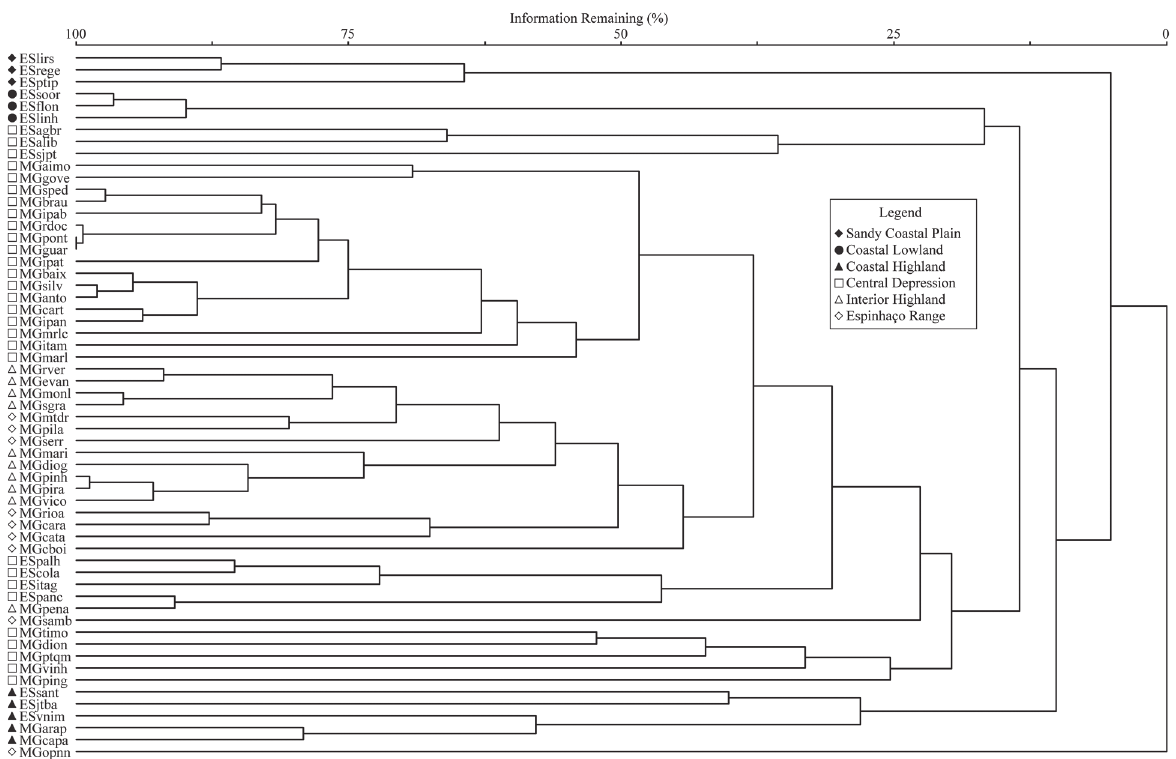
Figure 2 - Cluster analysis (UPGMA) for 59 sites (including outliers) within the Doce River Basin, southeastern Brazil. Legend of symbols is available in Figure 1. The codes of sites are described in Table